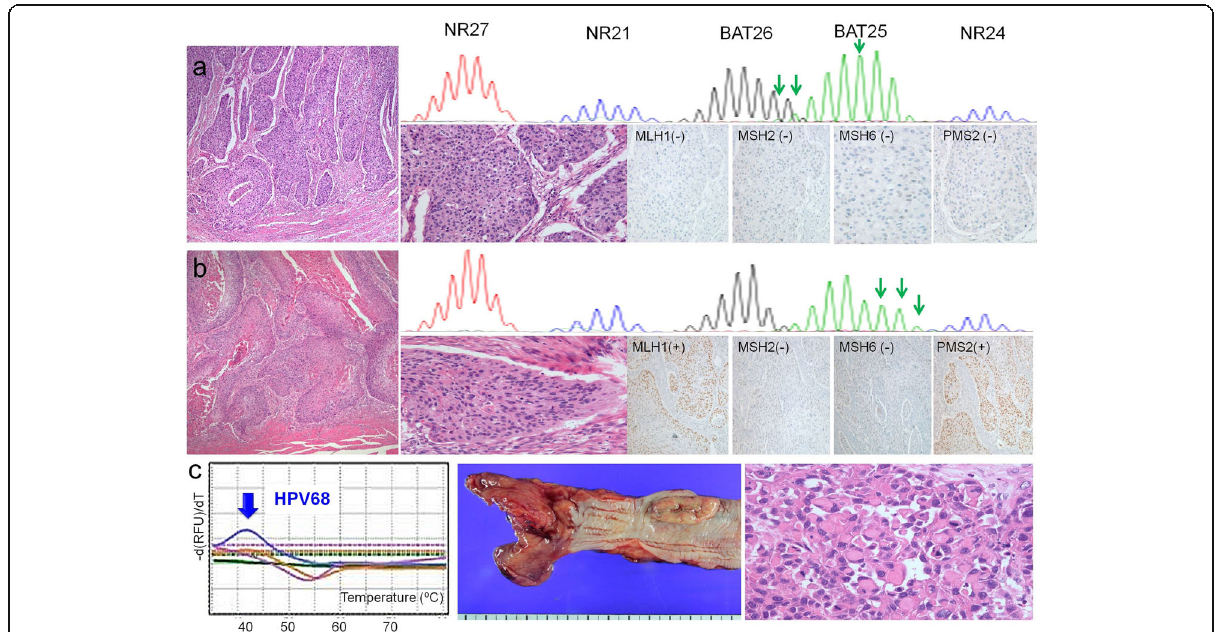
Fig. 2 a - b Representative images of microsatellite instability-low and the corresponding immunohistochemical results of mismatch repair proteins and histological findings. ( a ) BAT25 marker showing microsatellite instability and lack of immunohistochemistry of MLH1, MSH2, MSH6, and PMS2 are noted in the poorly-differentiated squamous cell carcinoma with high tumor infiltrating lymphocytes. b BAT25 marker showing microsatellite instability and lack of immunohistochemistry of MSH2 and MSH6 are observed in the well-differentiated squamous cell carcinoma with low tumor infiltrating lymphocytes. c Real-time peptide nucleic acid probe-based fluorescence melting curve analysis reveals the HPV68 genotyping. A fungating mass (3.5 × 1.8 × 0.8 cm) is observed in the lower portion of esophagus. Poorly-differentiated esophageal squamous cell carcinoma with discohesive tumor